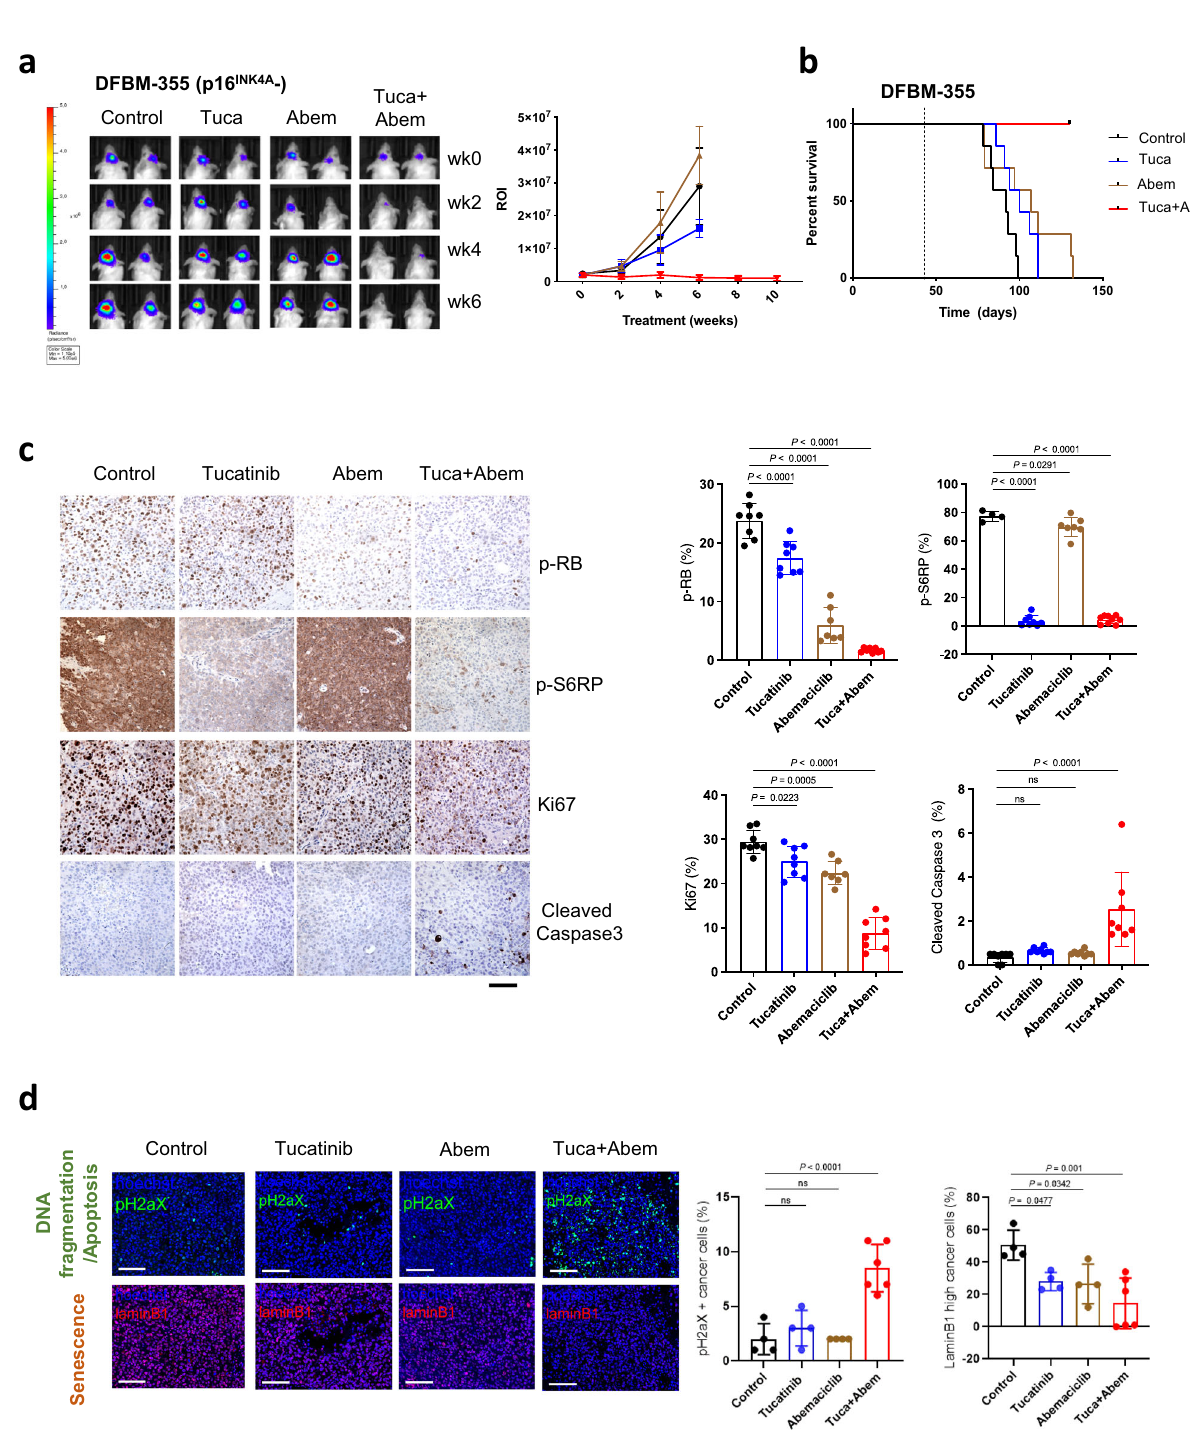
Fig. 1 CDKN2A copy number variation and p16 INK4A -de fi ciency are found in a majority of HER2 + BCBM PDXs. a Genomic analysis of genes associated with cell cycle pathway in BCBM PDXs. Major genetic alterations across 30 BCBM PDX samples. b CDKN2A mRNA expression levels across BCBM PDXs. Each dot represents one PDX model: HER2 + /ER − ( n = 10), HER2 + /ER + ( n = 10), ER + /HER2 − ( n = 8), triple negative (TN) ( n = 8), mean ± SD, one-way ANOVA followed by Tukey ’ s multiple comparisons test. c Heatmap of CDKN2A and RB1 mRNA levels across BCBM PDXs. d Bar plot of p16 INK4A positive cells by immunohistochemistry (IHC) per HER2 + PDX model with CDNK2A copy number variation (CNV) shown below. p16 INK4A positive cells shown as mean ± SD of three images per section per sample. e p16 INK4A IHC of the indicated BCBM PDXs (Scale bar, 50 μ m). HCC70 xenograft tumor sections were used as a positive control. f Comparison of p16 INK4A positive cells in HER2 + BCBM PDX and matched patient samples ( n = 11, mean ± SD). Mean PDX p16 INK4A positive cells 9.7 ± 3.4%, mean patient p16 INK4A positive cells 33.6 ± 8.9%, p = 0.06. ns: not signi fi cant. g Proportion of patients in our BCBM cohort either negative or positive for p16 INK4A expression based on 30% cutoff. Source data are provided as a Source Data fi